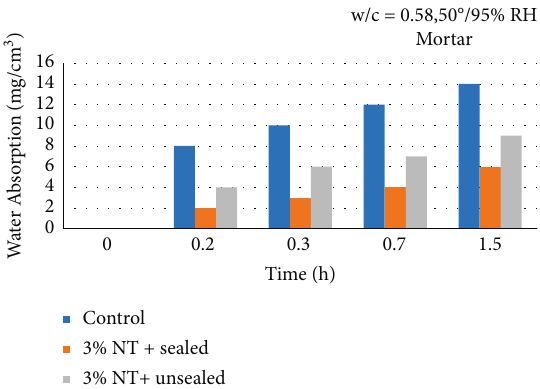
Figure 4: Time vs. water absorption of trail data with 50 °